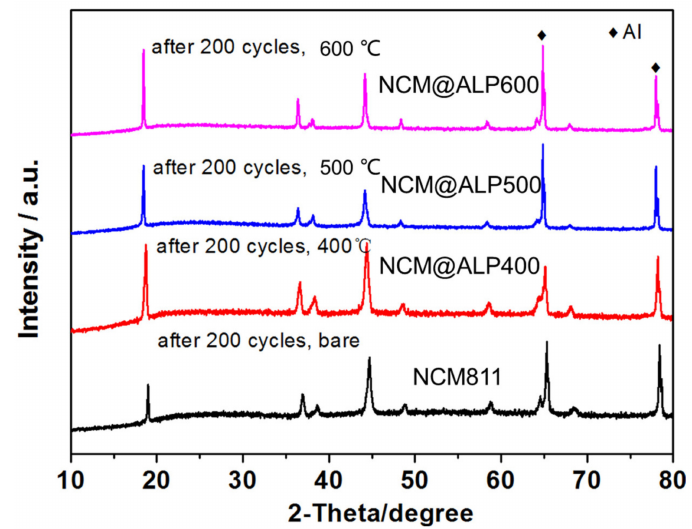
Figure 7. XRD patterns of bare NCM811 and NCM811@ALP samples after 200 charge–discharge cycles.